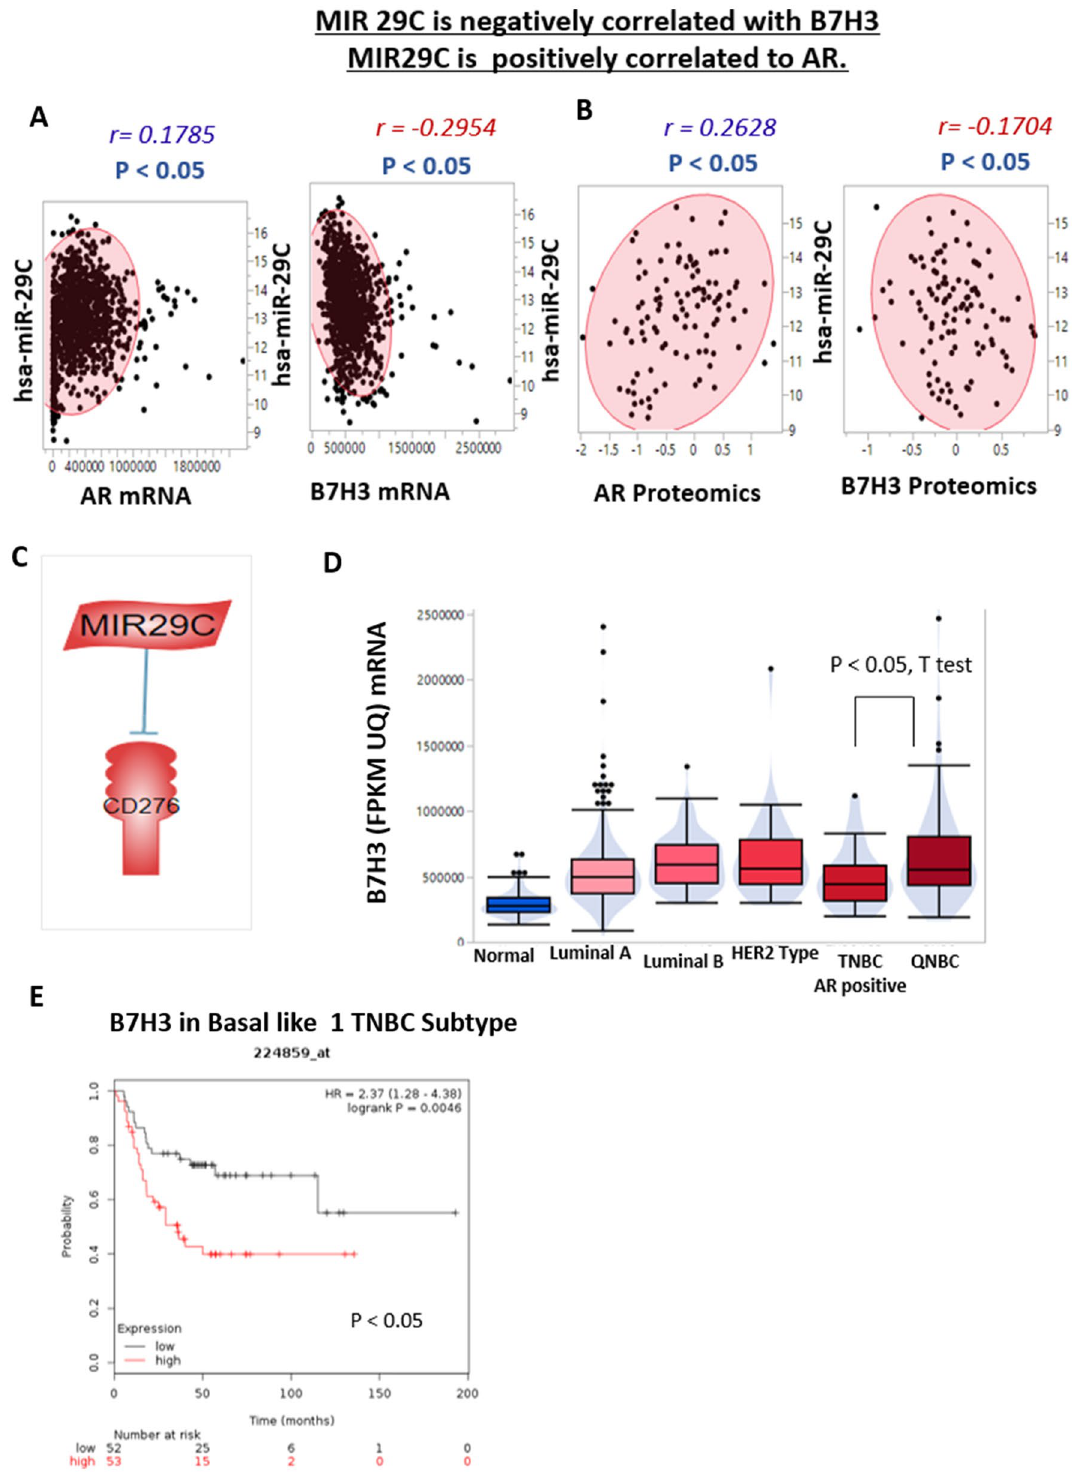
Figure 6. Correlations of AR, miR29C, and B7H3. AR positively correlated with mir-29C, which negatively correlates with B7H3. B7H3 is high in QNBCs compared to AR-positive TNBCs. In TNBCs, high B7H3 is associated with lower survival of patients with the basal-like 1 subtype. Non-parametric t-test p -values are indicated. ( A ) Correlation scatter plots show the Pearson correlation coefficients. In mRNA data (n = 1083) for TCGA overall primary tumor samples, mir-29C positively correlates with AR and negatively correlates with B7H3. ( B ) In proteomics data for TCGA overall primary tumor samples (n = 105), mir-29C positively correlates with AR and negatively correlates with B7H3. ( C ) Pathway Studio analysis revealed that mir-29C targets CD276/B7H3, which is located on the cell membrane and known to be clinically relevant. ( D ) The box plot shows the mRNA gene expression of B7H3 in FPKM UQ units. As compared to healthy tissues, B7H3 expression was higher in primary breast cancer tissues of different BC subtypes. B7H3 expression was higher in QNBCs as compared to AR-positive TNBCs. ( E ) Survival analysis was accomplished with KM Plotter with breast cancer datasets for B7H3 (probe ID 224859_at) by the Pietenol subtypes of TNBCs. Patients with high B7H3 in basal-like 1 TNBCs have lower